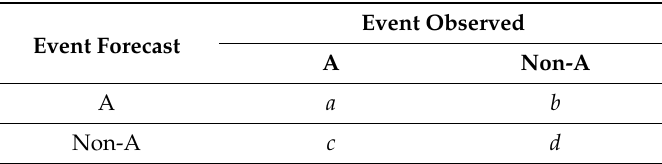
Figure 12. Comparison of forecasted ZTDs and GPS-ZTDs at the ( a ) AMU2, ( b ) BACK, and ( c ) DUPT stations (black solid line: six-hour forecast result; brown solid line: 12 h forecast result; light blue solid line: 24 h forecast result). Table 4. Heidke Skill Score